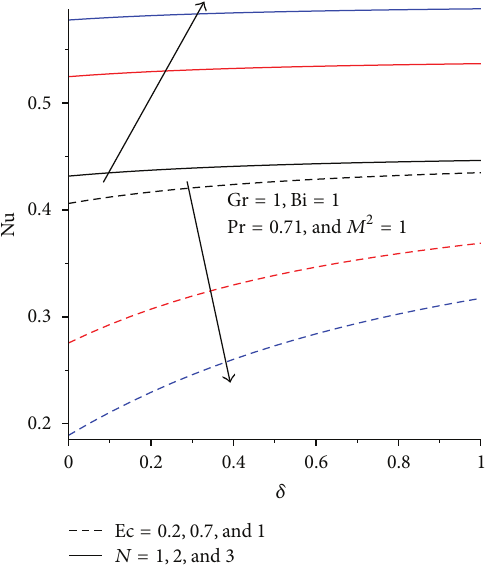
Figure 21: The Nusselt number with increasing Ec, 𝑁 , and 𝛿 .